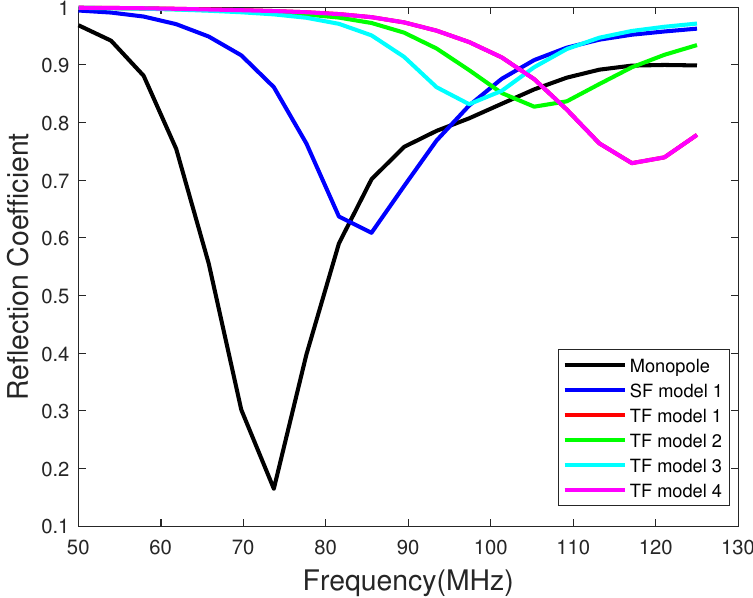
Figure 11. Reflection coefficient vs. the frequency of